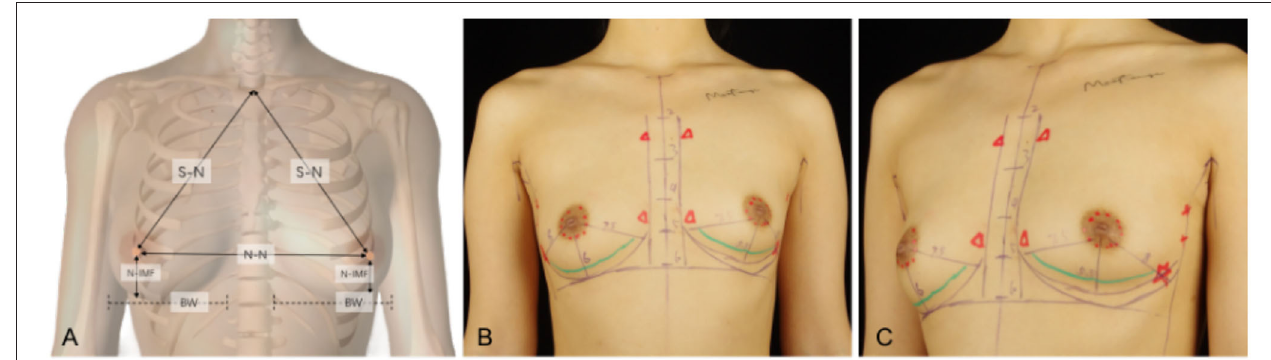
FIGURE 1 | Some key indicators of the patients, including approximate projection of chest blood vessels and nerves on the body surface, inframammary sulcus line of the breast before and after breast augmentation, anterior axillary line, fovea jugularis, parasternal line, breast boundary line, distance from sternal notch to nipple (S-N), breast base width (BW), distance from the nipple to the inframammary fold (N-IMF), the distance between breasts (N-N). (A) Some indicators show in a schematic diagram. (B) Marking on the clinical case, a 26-year-old patient with a transaxillary breast augmentation with endoscopy. Breast augmentation with endoscopy under anatomy instruction frontal views. (C) Breast augmentation with endoscopy under anatomy instruction oblique views.